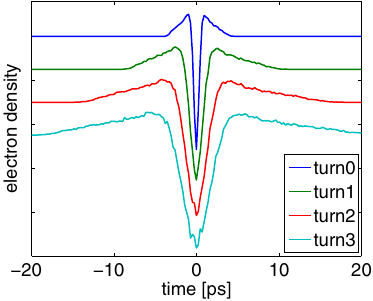
FIG. 2. Simulated charge distribution of the sliced bunches as a function of time from turn 0 to turn 3. The curves are shifted vertically for better